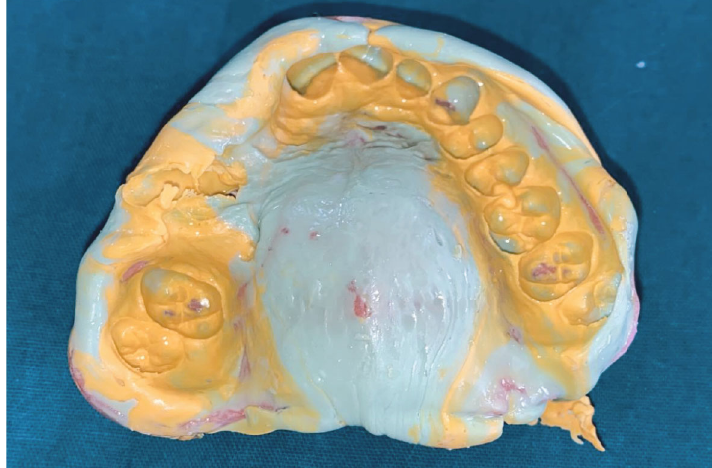
Figure 5: De fi nitive impression following mouth preparation.